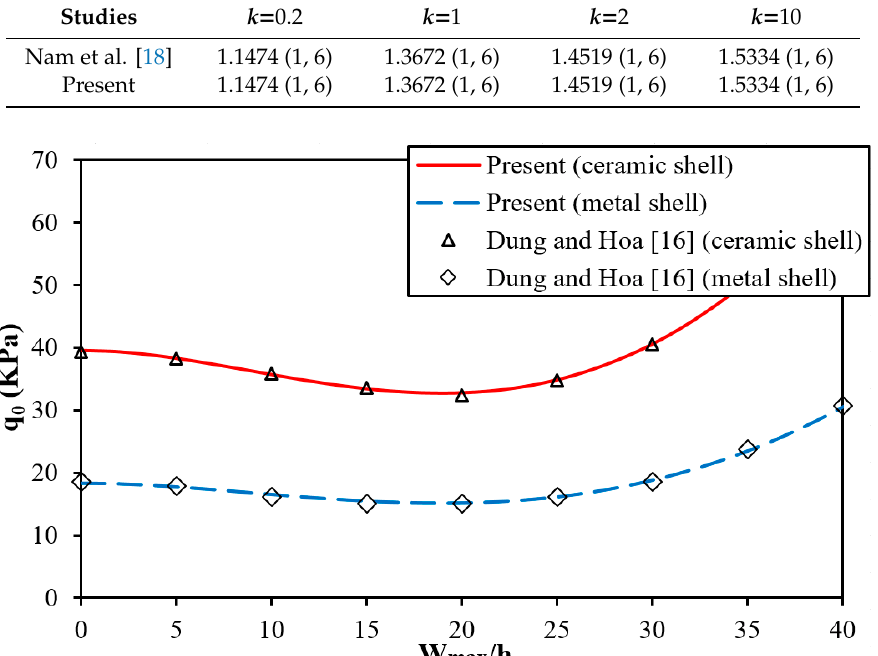
Table 2. Comparison of the upper critical buckling pressure (MPa) of a sandwich FGM cylindrical shell and previous results (